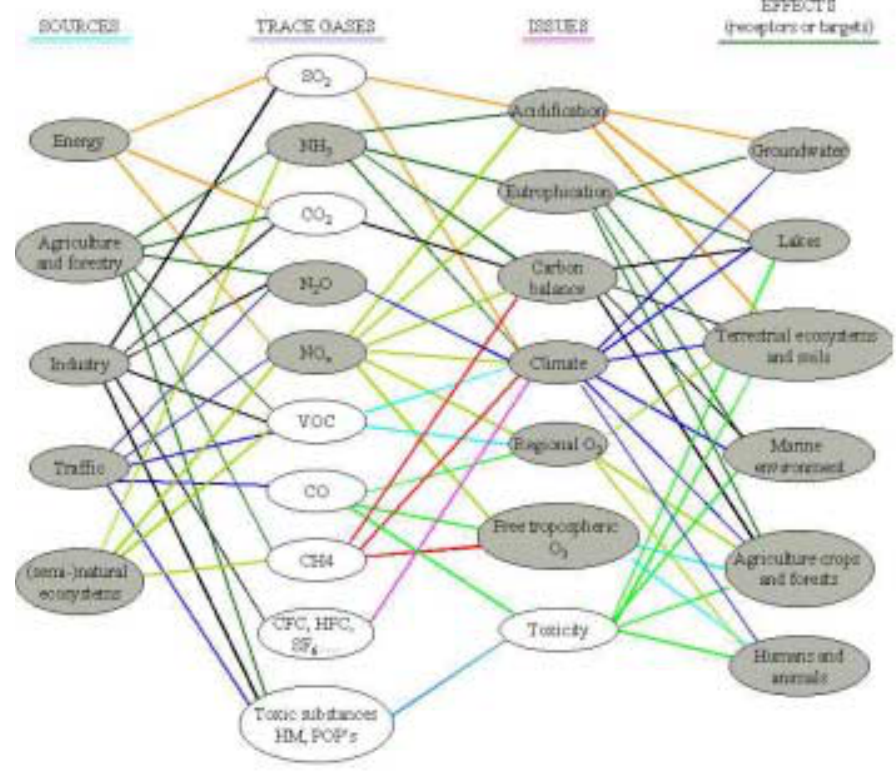
FIGURE 8. The interrelations between sources, compounds, environmental issues and receptors, with a focus on the atmospheric components. Ellipses shown in grey indicated problems linked to the N cycle. Modified from